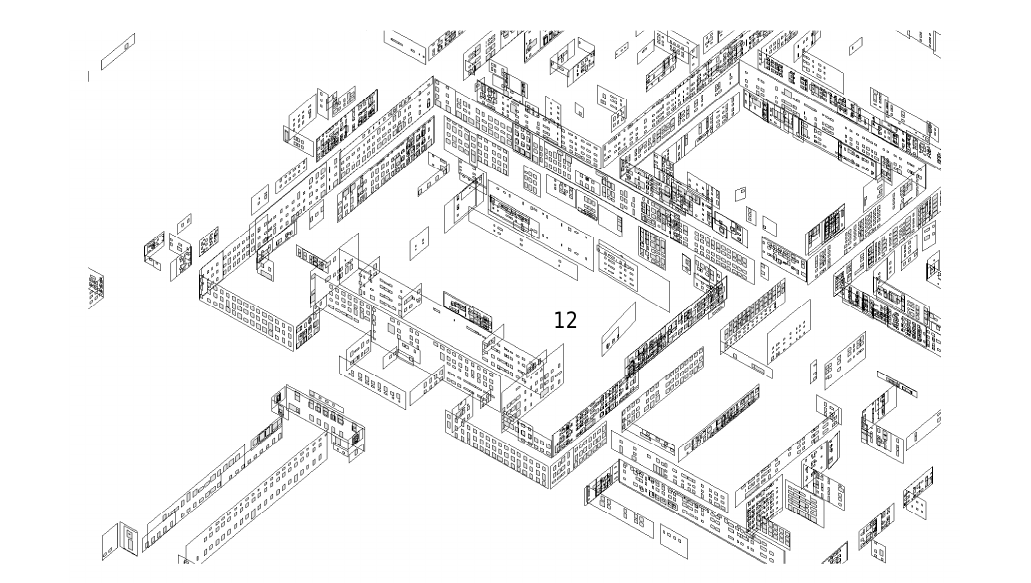
Figure 6. Final result with detected façade planes and reconstructed windows